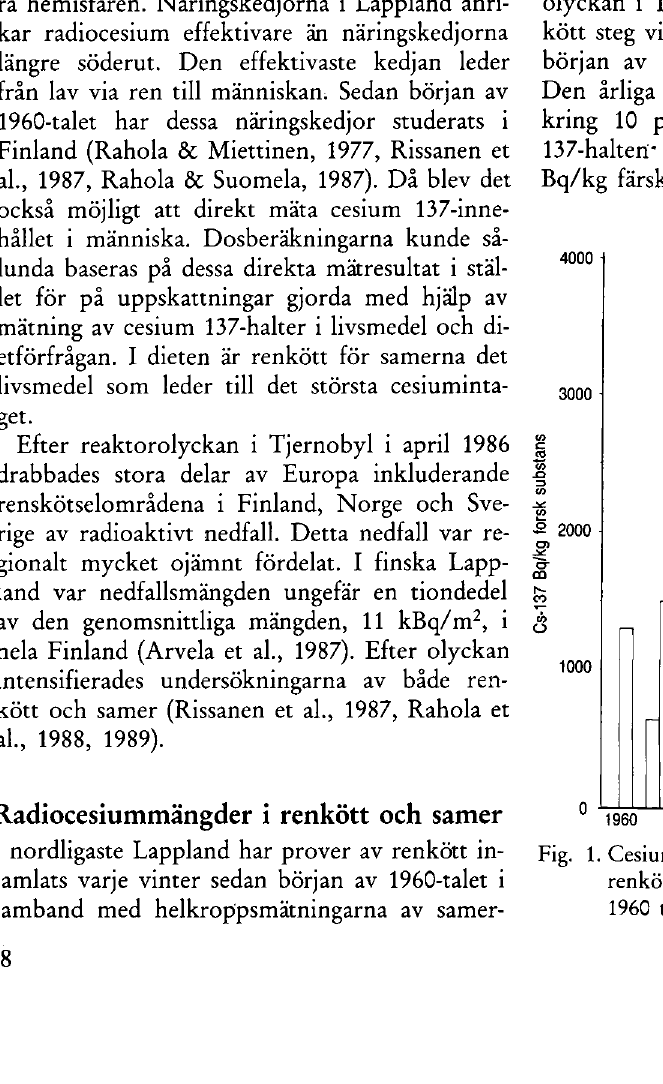
Fig. 1. Cesium 137-halterna, Bq/kg fàrsk substans, i renkott från Enareområdet om vintern. från 1960 till